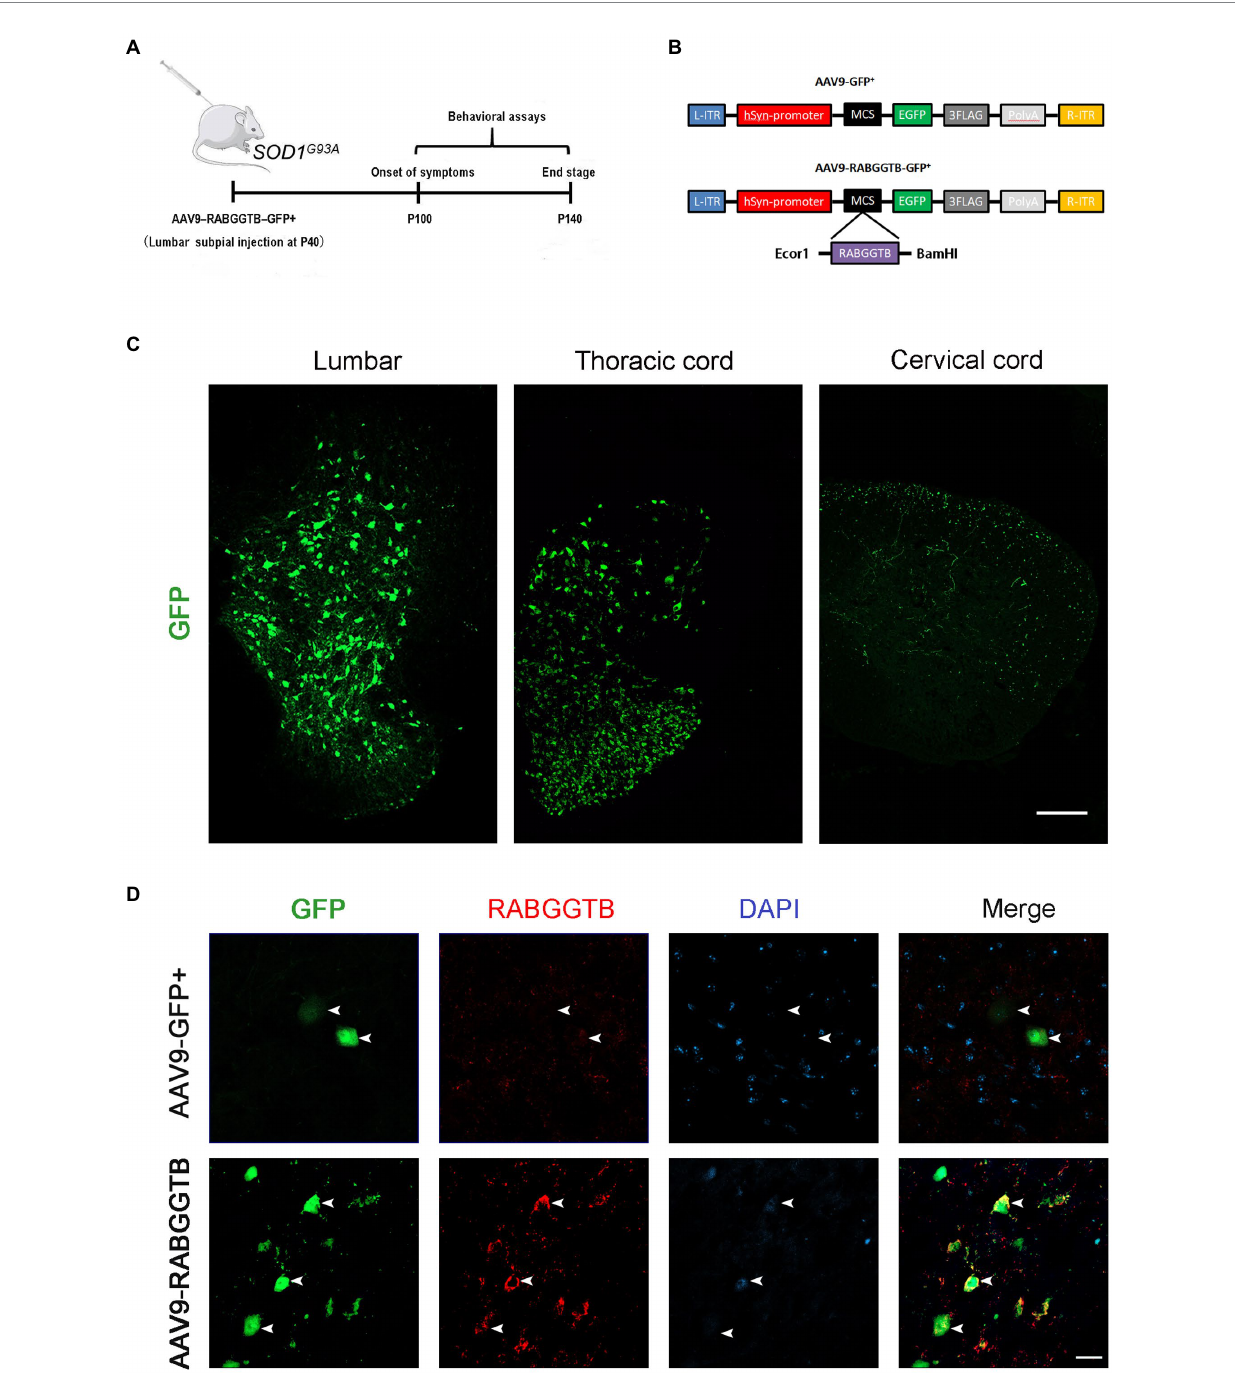
FIGURE 2 Efficient and specific GFP expression in motor neurons and efficient RabGGTB overexpression. (A) Schematic diagram of the experimental design. (B) The AAV9-RabGGTB-GFP + and AAV9-GFP + vector design is shown. (C) Representative immunofluorescence labeling of GFP (green) in the lumbar, thoracic and cervical regions of spinal cord (scale bar: 150 μ M). (D) Immunofluorescence labeling of RabGGTB (red) in GFP-positive motor neurons (green) at 3 weeks after intrathecal injection with the virus (scale bars, 50 μ